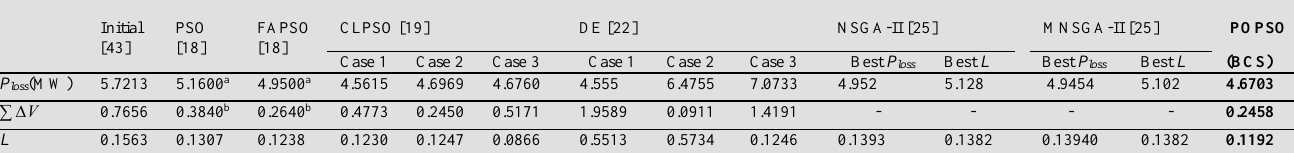
Table 5. Comparison of POPSO with other techniques on IEEE 30-bus test system